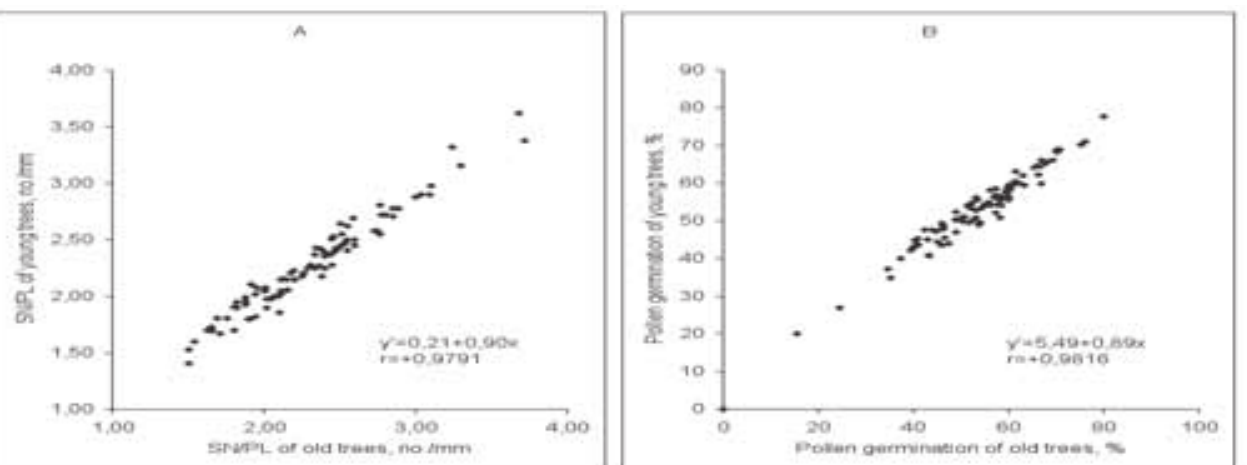
Figure 2. Characterization of sexual organs on various old plum trees